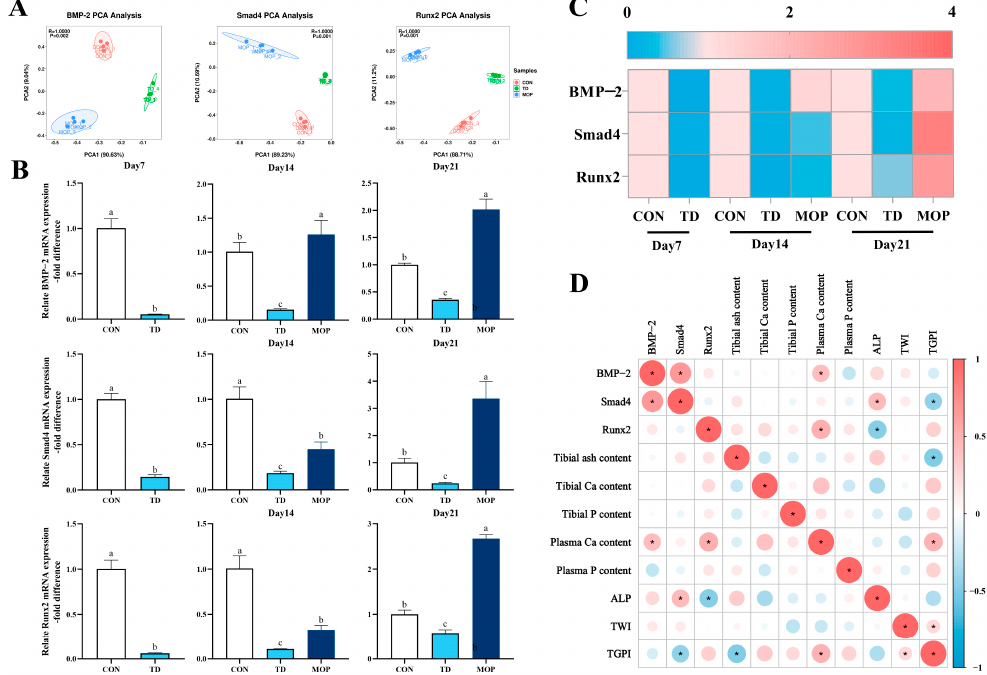
Figure 4. Effects of MOP on bone formation-related genes in TD broilers. ( A ) PCA of the BMP-2, Smad4, and Runx2 gene expressions with an unsupervised pattern recognition method. ( B ) BMP-2, Smad4, and Runx2 gene expression. ( C ) Heatmap shows the expression of genes associated with antioxidant activity. ( D ) Pearson correlation analysis between BMP/Smads signaling pathway and bone metabolism-related parameters. TWI: Tibial weight index; TGPI: Tibial plate index. Bars with no common small letters (a, b, c) indicate statistical differences among the three treatments ( p < 0.05).